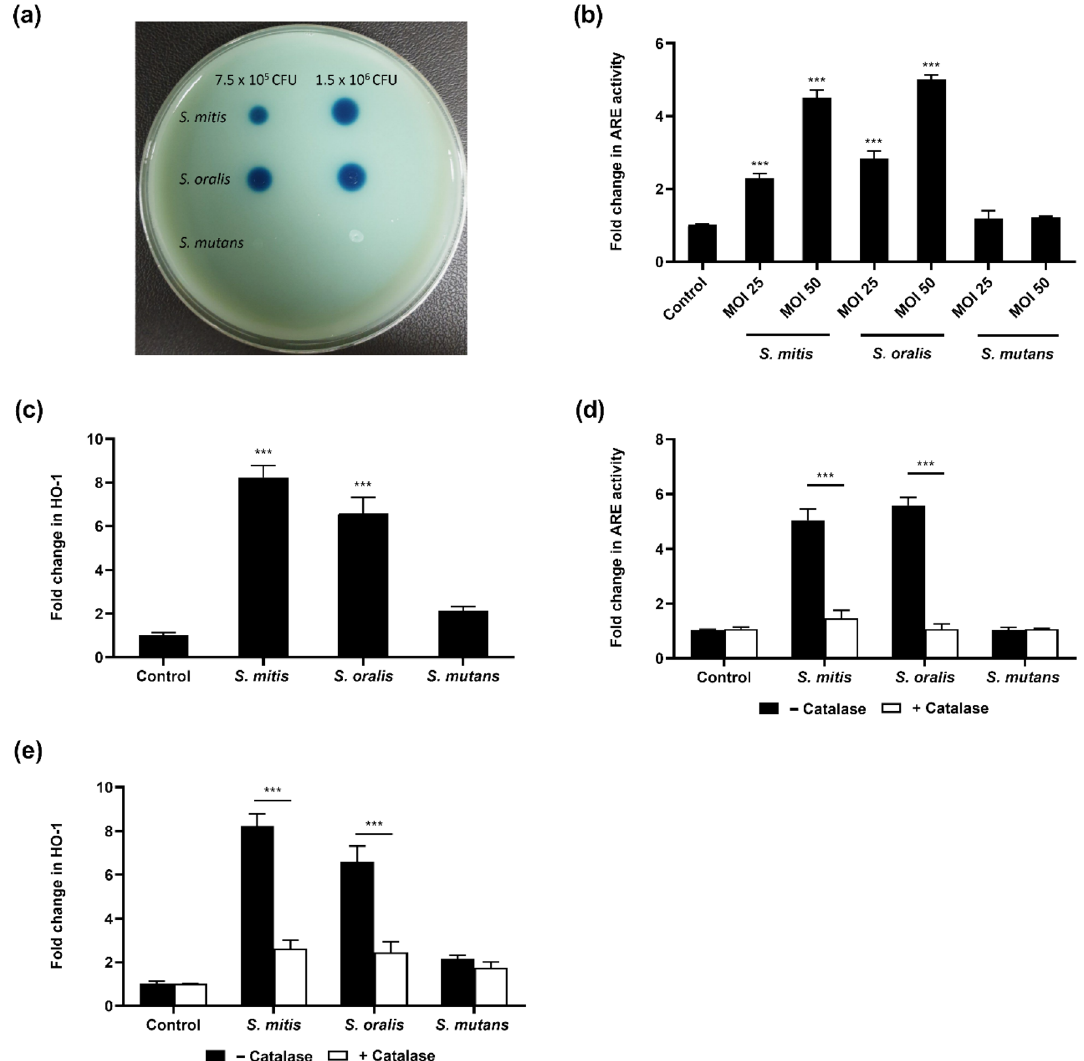
Figure 1. H 2 O 2 producing oral streptococci activated the Nrf2-ARE pathway. ( a ) The amount of H 2 O 2 produced by oral streptococci was determined by the formation of blue halos on Prussian blue agar plates. ( b ) Raw 264.7 cells stably expressing the ARE-SEAP reporter were infected with S. mitis , S. oralis or S. mutans at the indicated MOIs. Cellular Nrf2-ARE activity was quantified by SEAP reporter assay. The expression of ( c ) HO-1 were determined by qRT-PCR. Raw 264.7 cells stably expressing the ARE-SEAP reporter were infected with S. mitis or S. oralis at MOI 50:1 in the presence and absence of 25U/mL of catalase. ( d ) ARE activity was determined by SEAP reporter assay while the expression of ( e ) HO-1 were determined by qRT-PCR. ***p < 0.001 compared to the respective control Activation of Nrf2-ARE by oral streptococci H O inhibited the NFĸB signalling pathway. To 2 2 determine if the activation of the host antioxidant pathway could potentially inhibit the innate immune response of macrophages, Raw 264.7 cells were treated with ML385, a Nrf2 inhibitor. It was observed that treatment of macrophages with ML385 led to the inhibition of S. mitis or S. oralis mediated Nrf2-ARE activation (Fig. 5a), and downregulation of the expression of HO-1 and GPx-3 (Fig. 5b, Supplementary Fig. 4). However, the inhibition of Nrf2 pathway led to enhanced NFĸB activation and potentiation of TNF-α and IL-1β production (Fig. 5c–e). ML385 did not affect the viability of the macrophages and bacteria (Supplementary Fig. 5). To confirm these results, Nrf2 -/- Raw 264.7 cells were engineered (Supplementary Fig. 6). While the expression of HO-1 and GPx-3 increased significantly in the control macrophages following infection with S. mitis or S. oralis (Fig. 6a, Supplementary Fig. 7), this change was not observed in Nrf2 -/- macrophages, providing evidence that these antioxidant genes were under the regulation of Nrf2. In Nrf2 -/- macrophages, treatment with S. mitis or S. oralis led to enhanced TNF-α and IL-1β levels compared to wild-type macrophages, demonstrating that activation of Nrf2 suppressed the innate immune response (Fig. 6b,c).